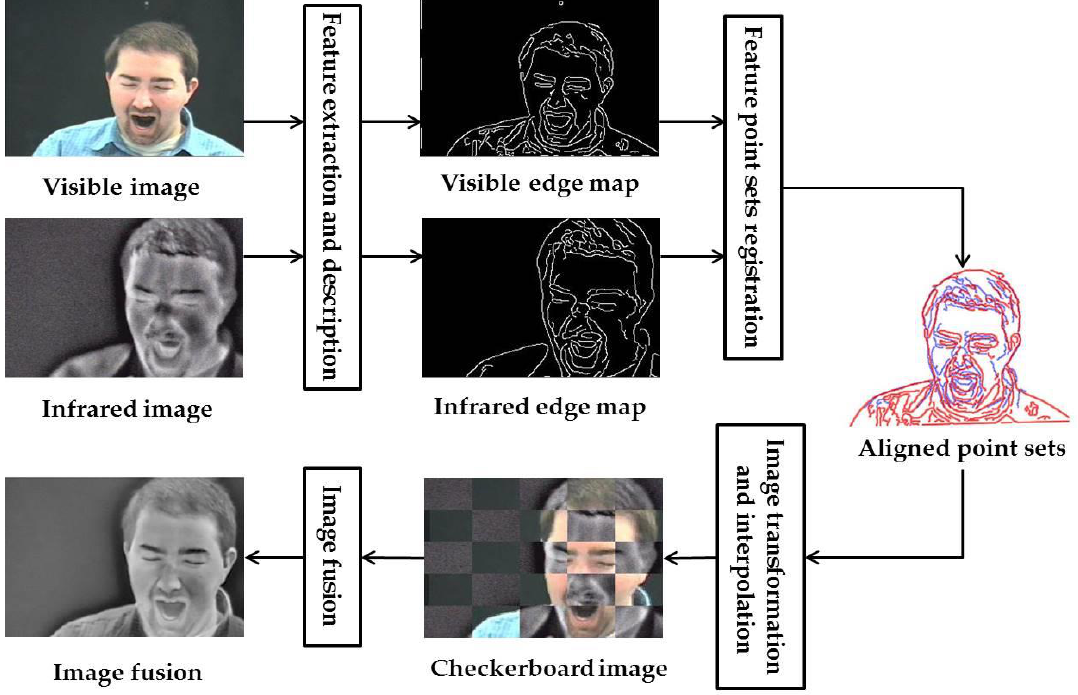
Figure 1. Visible and infrared face images fusion basic process for software-based registration.